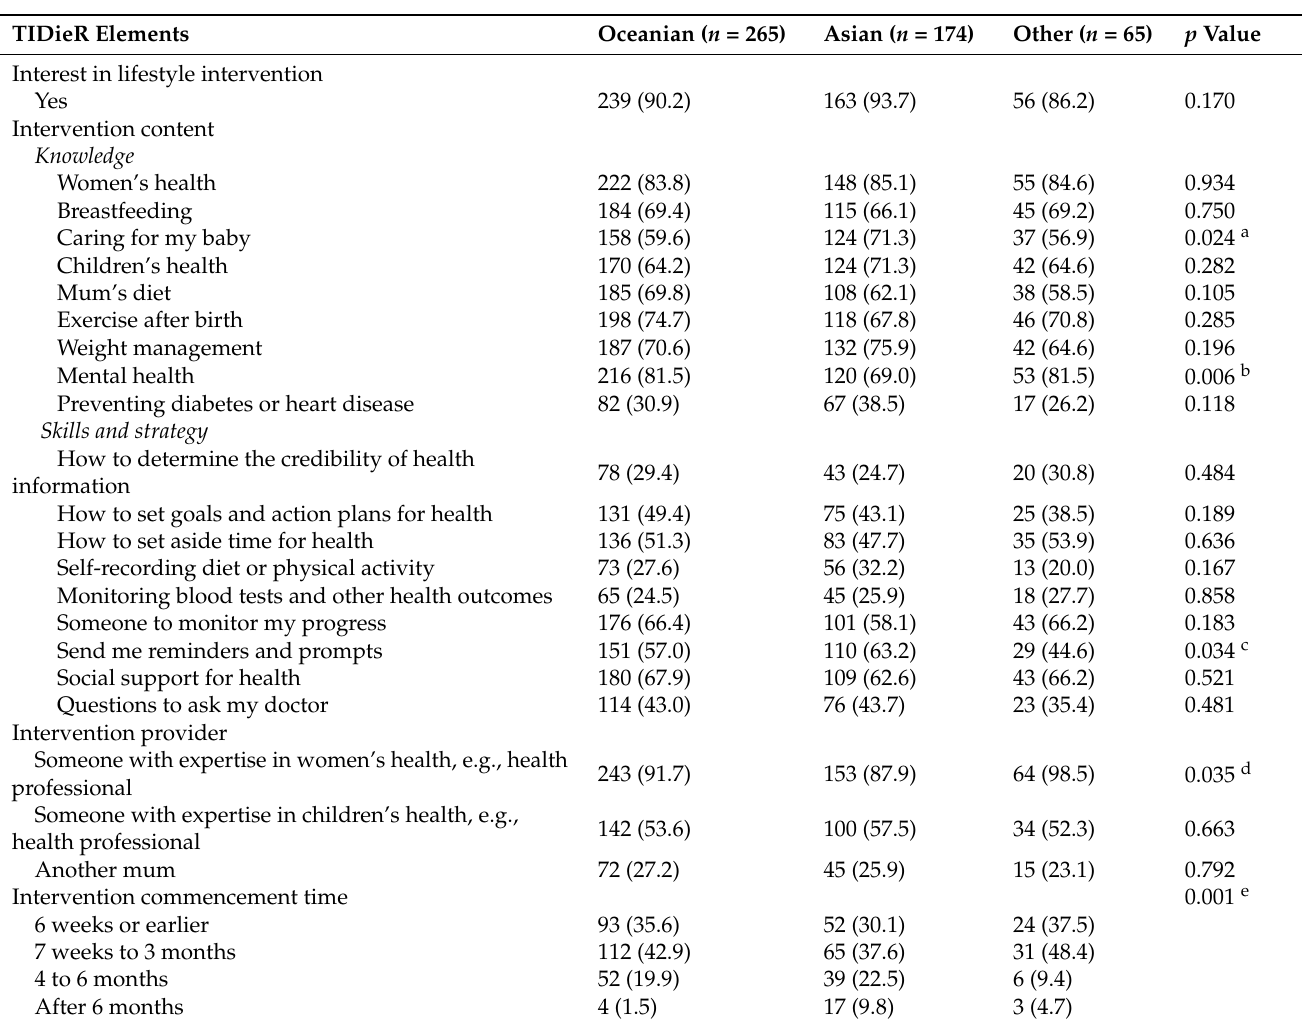
Table 2. Survey responses to the preferences for lifestyle intervention after childbirth according to TIDieR